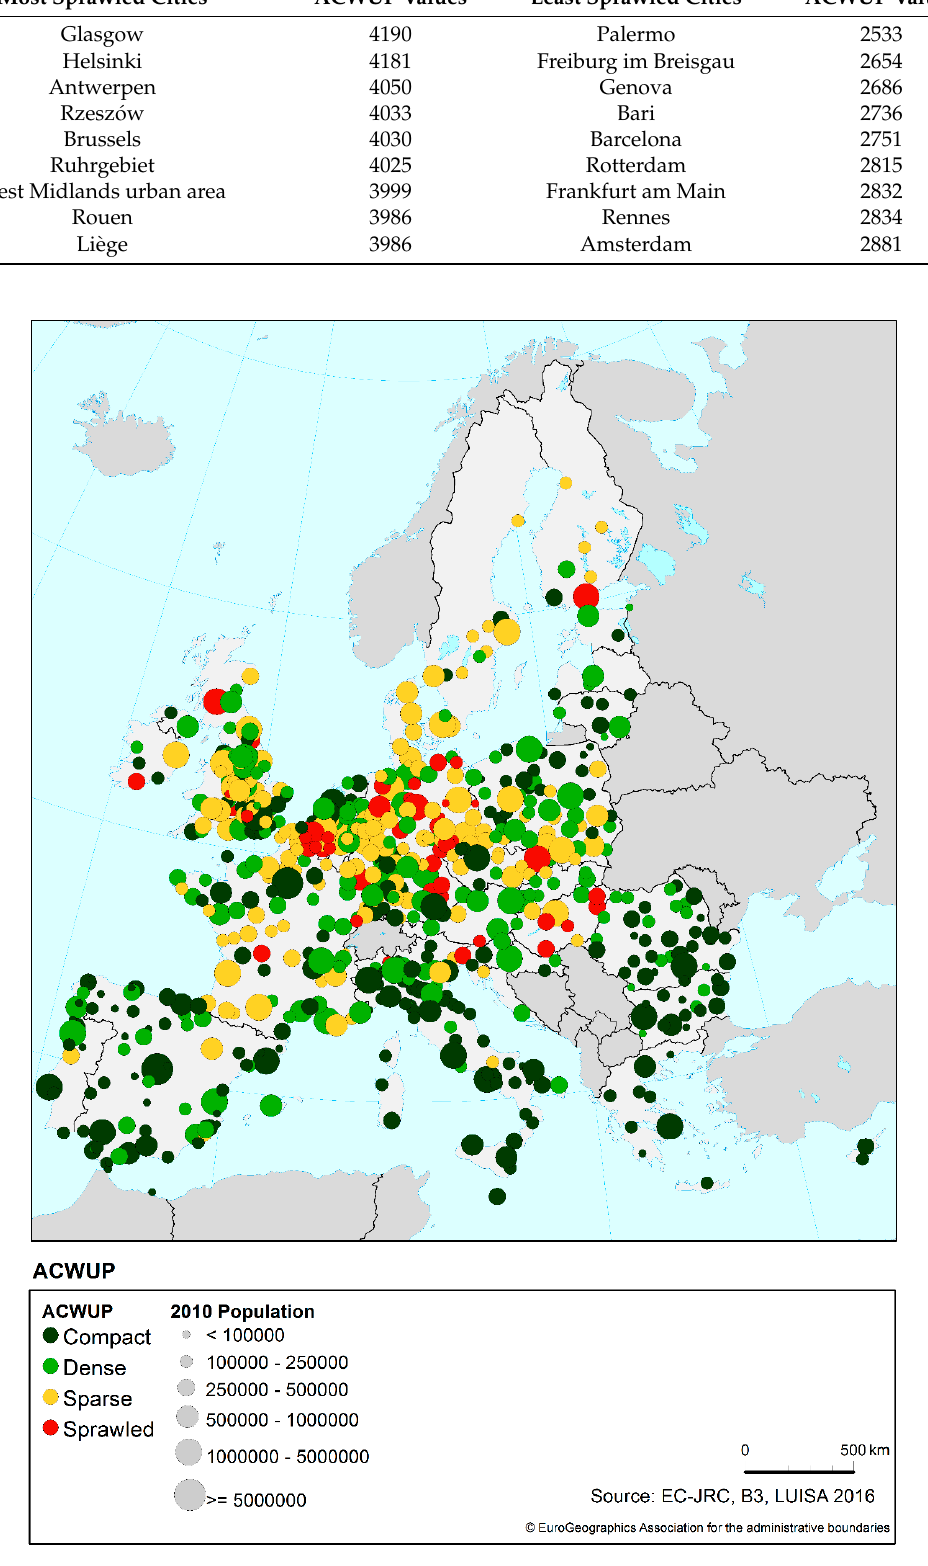
Figure 13. Application of the ACWUP indicator to all cities in the EU28 for 2010.